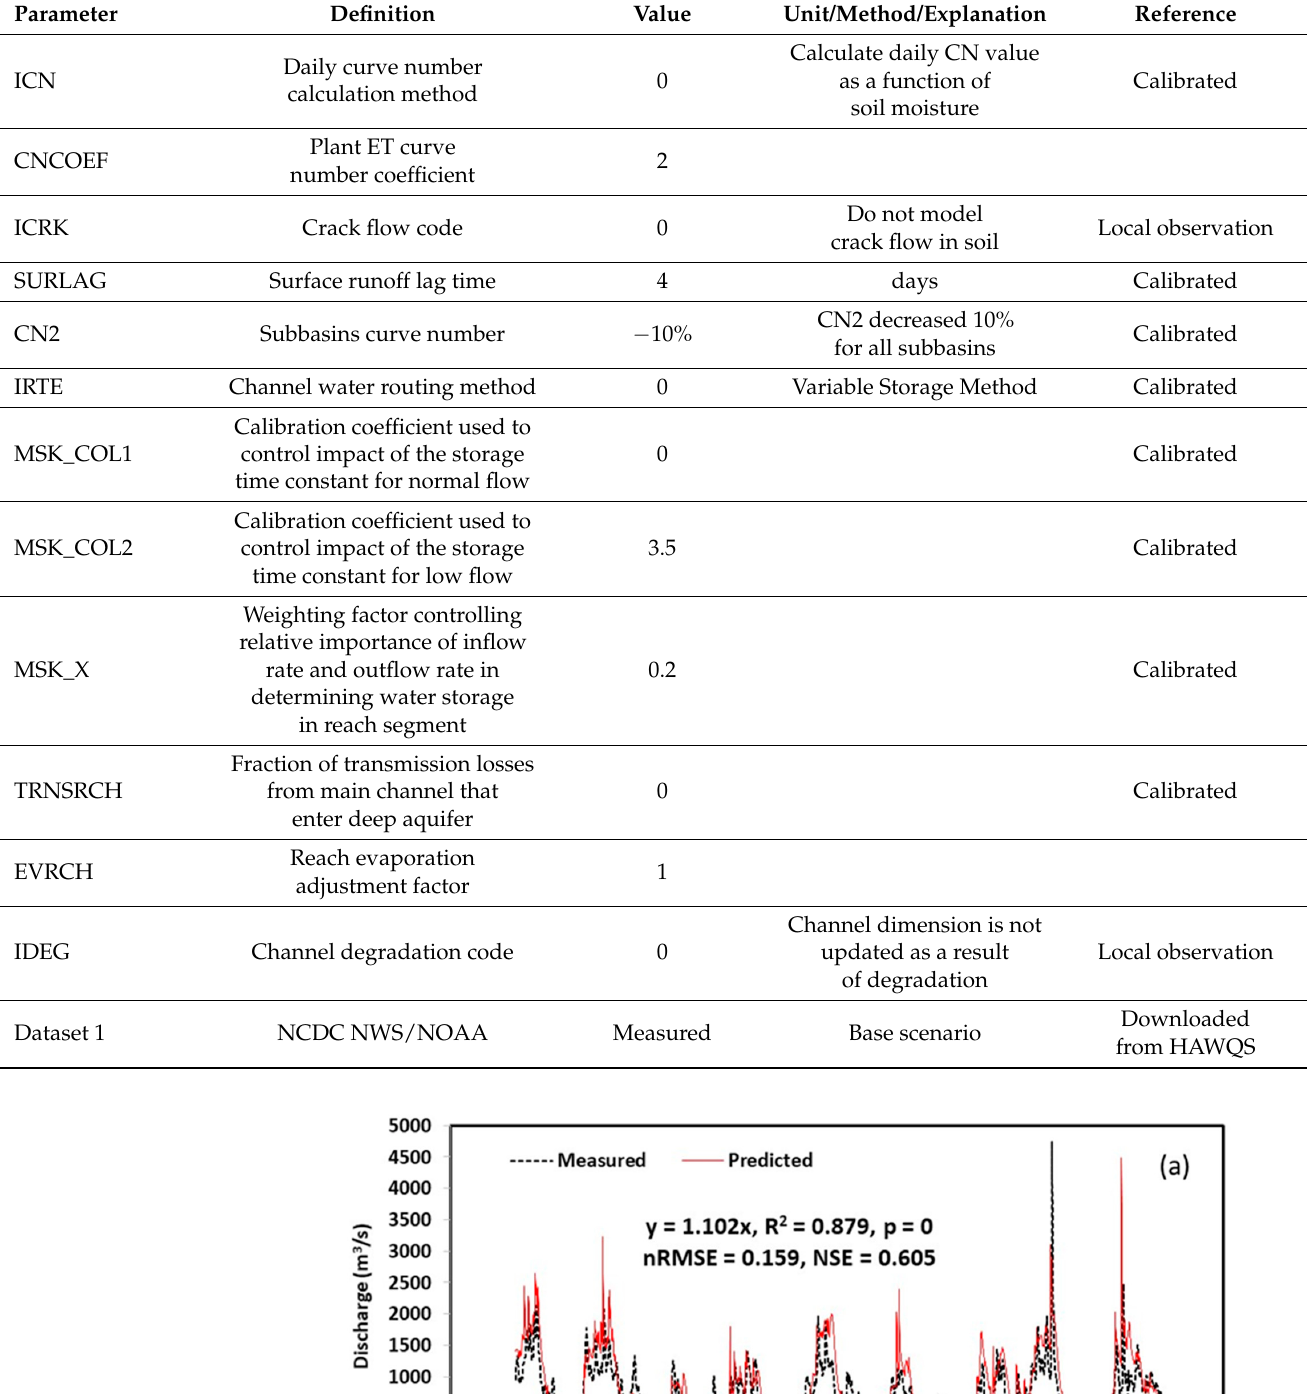
Figure 2. Comparison of the observed and predicted daily discharges during model calibration ( a ) and validation ( b ). The ACFRB model was validated by comparing the daily stream discharges between model predictions and field observations for a 16 ‐ year simulation period from 1 January 1993 to 31 December 2016 (Figure 2b). During model validation, the input parameter val ‐ ues were the same as those used during model calibration. With values of R 2 , the nRMSE, the NSE, and p of 0.817, 0.702, 0.627, and 0, respectively (Figure 2b) that were comparable to those of model calibration, we demonstrated that very good agreement was achieved between the predicted and observed daily discharges during model validation.